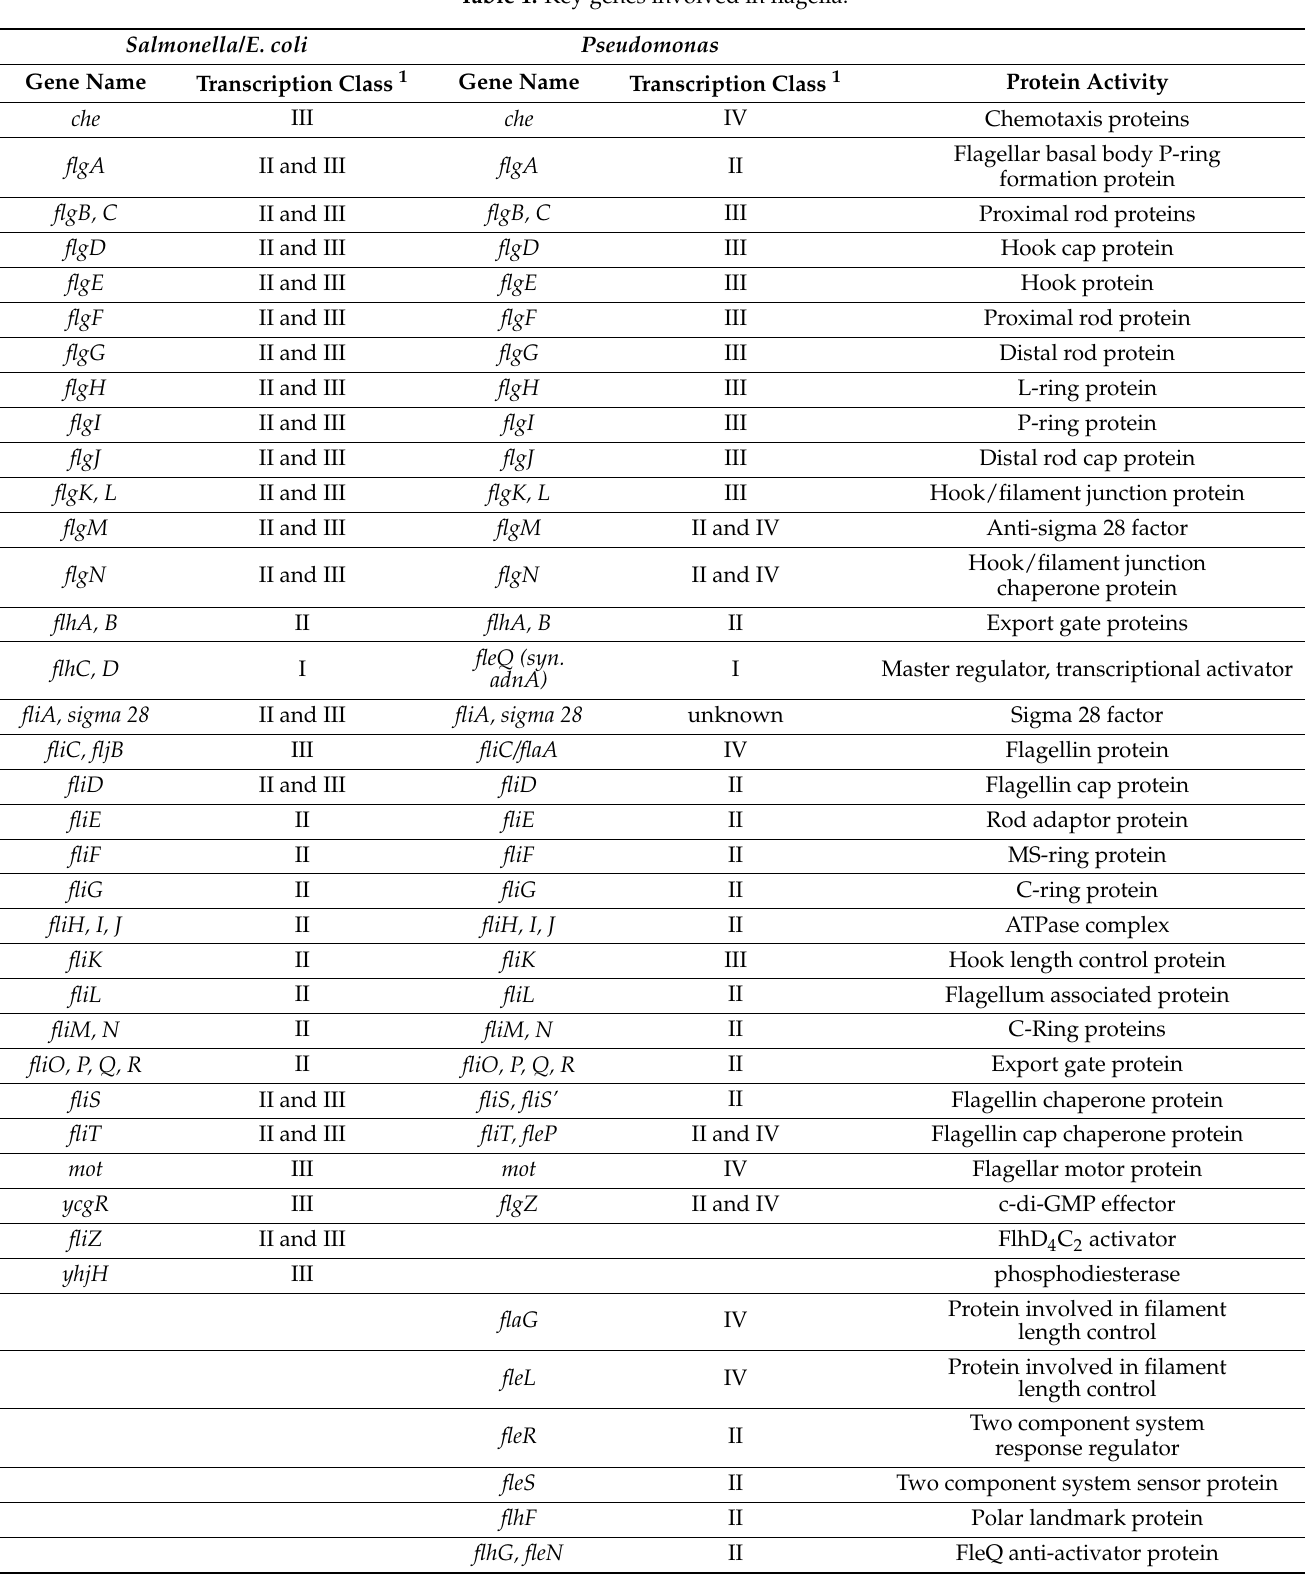
Table 1. Key genes involved in